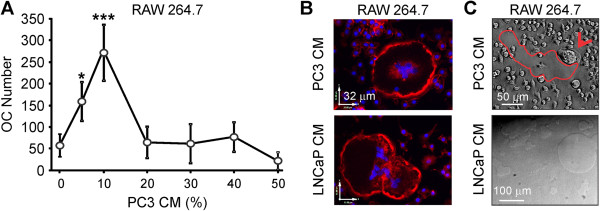
Osteoclasts are induced by prostate cancer CM in a concentration-dependent manner, exhibit characteristic actin structure, and resorb calcified matrices. A) RAW 264.7 cells were first primed with 50 ng/ml RANKL for 2 days, then cultured for additional 2 days untreated (negative control), or exposed to different dilutions of PC3 CM , and the average number of osteoclasts was assessed. Data are means ± SEM; n = 3-10 experiments; *P < 0.05, ***P < 0.001 indicate significance compared to negative control as assessed by ANOVA following by Tukey posttest. B) RANKL-primed osteoclast precursors supplemented for 2 days with 10% CM of PC3 (top) or LNCaP (bottom) were fixed, actin filaments were labeled using Alexa Fluor® 568 phalloidin (red), and nuclei were counterstained with DAPI (blue). Representative images of actin rings in osteoclasts formed after exposure to prostate cancer CM. C) RAW 264.7 cells were placed on calcium phosphate substrates, primed with RANKL for 2 days, and exposed to 10% PC3 (top) or LNCaP (bottom) CM for 2 days. Top: Representative image of active multinucleated osteoclast (red arrow) forming a resorption pit (red outline). Bottom: Representative image of resorbed areas after osteoclasts were removed.